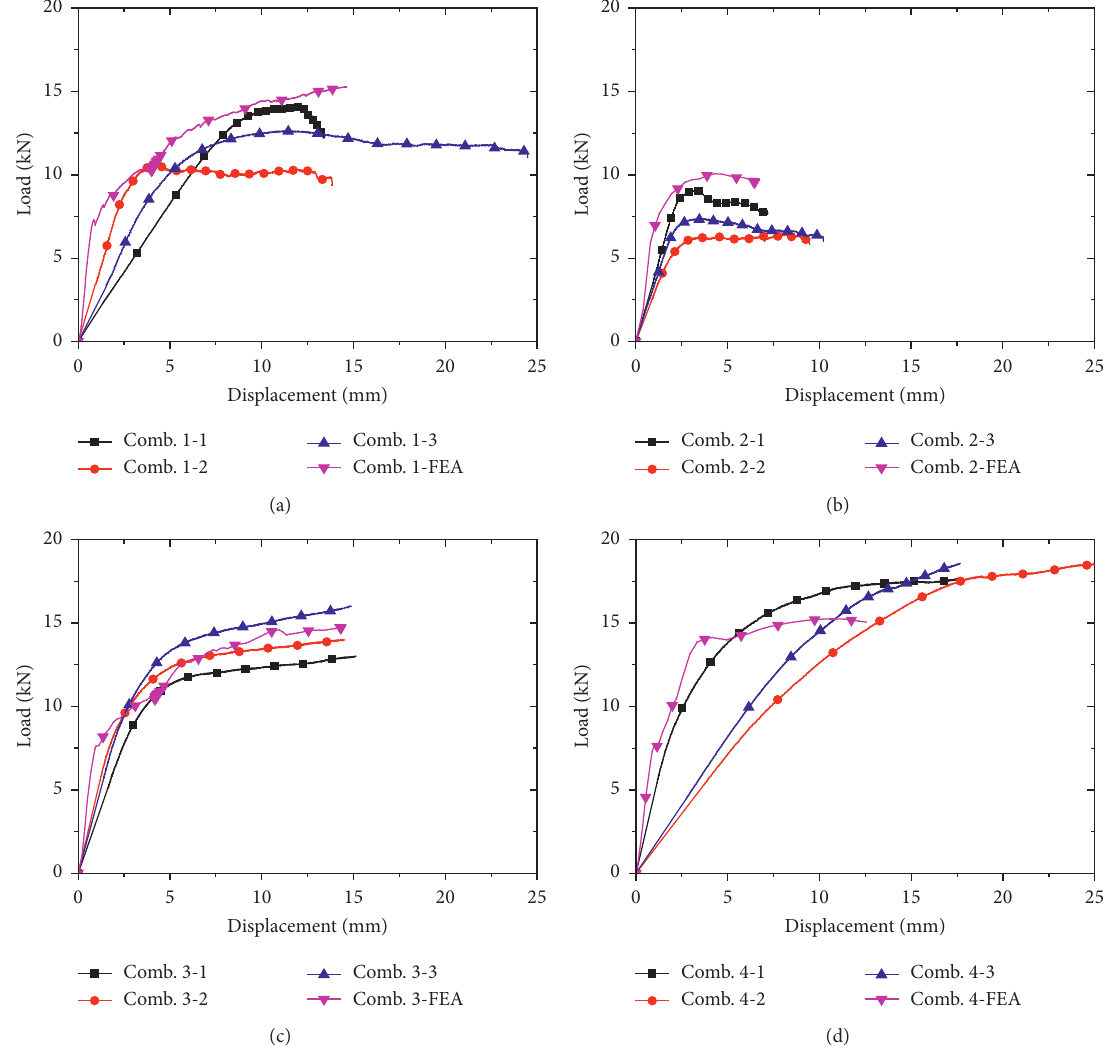
Figure 7: The load-displacement curves of single bolt connections: (a) combination 1: t t cm � 40mm and t sm � 10mm; (c) combination 3: t cm � 60mm and t sm � 30mm; (d) combination 4: t cm � 60mm and t sm �